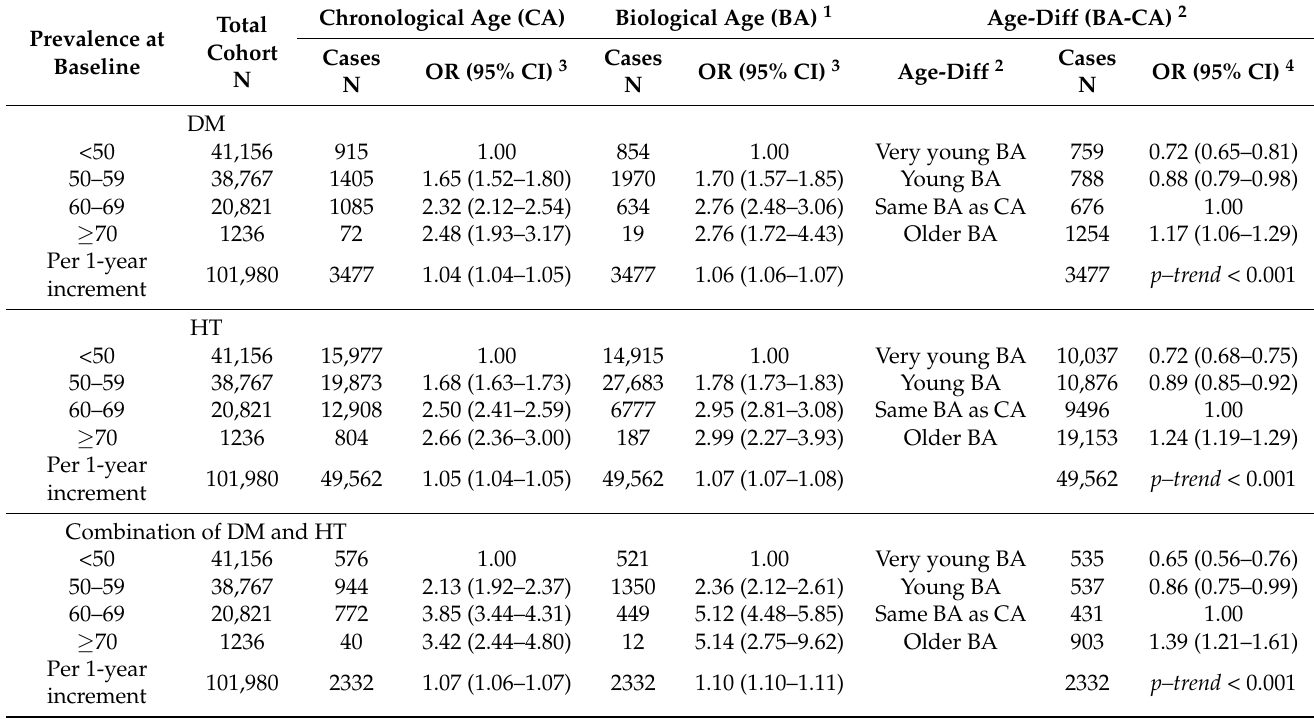
Table 1. Association with CA, BA, and Age-Diff on the likelihood for the prevalence of DM, HT, com- bination of DM and HT, and CKD at the baseline among 101,980 cohort participants in the